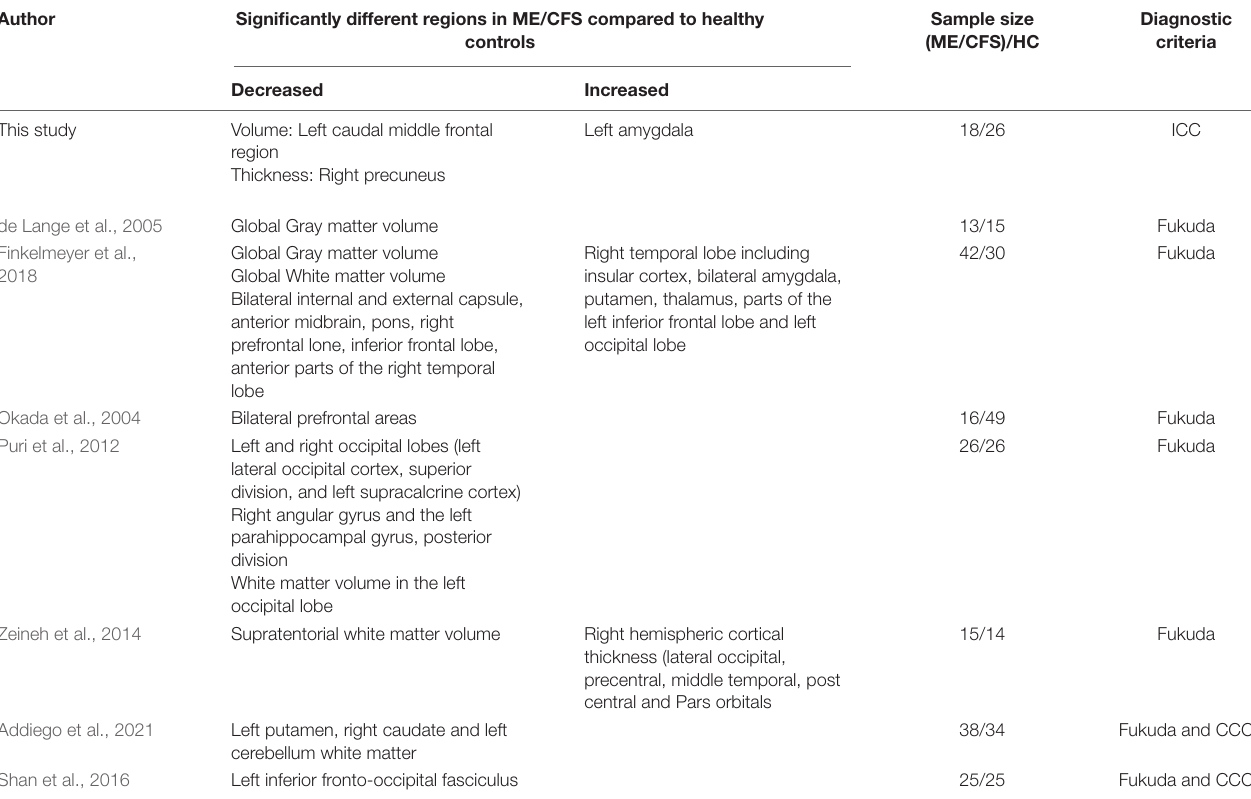
TABLE 3 | Different ME/CFS volumes reported here and in previous publications for both global and regional regions.